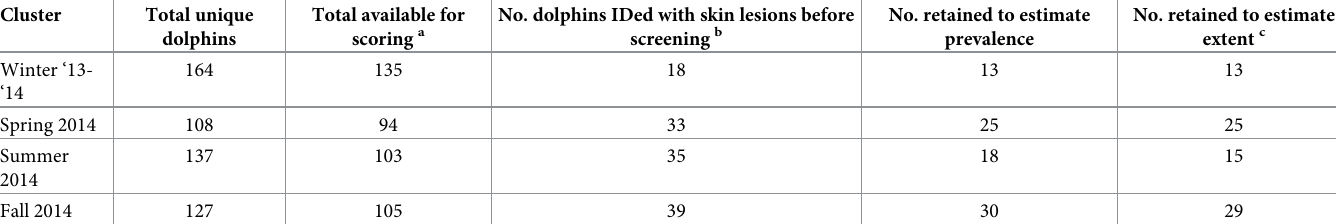
Table 1. Numbers of unique dolphins seen each season and the numbers of individuals utilized to estimate skin lesion prevalence and extent. Cluster